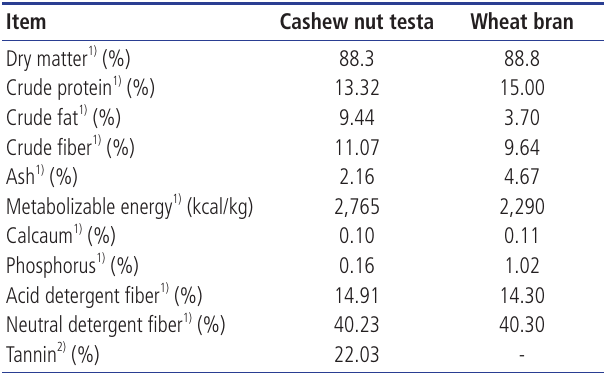
Table 3. Chemical composition of cashew nut teast and wheat